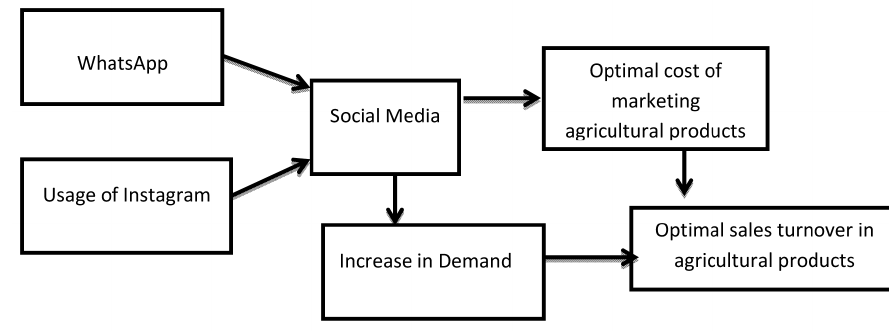
Figure 1. A model of social media marketing of agricultural products and sales